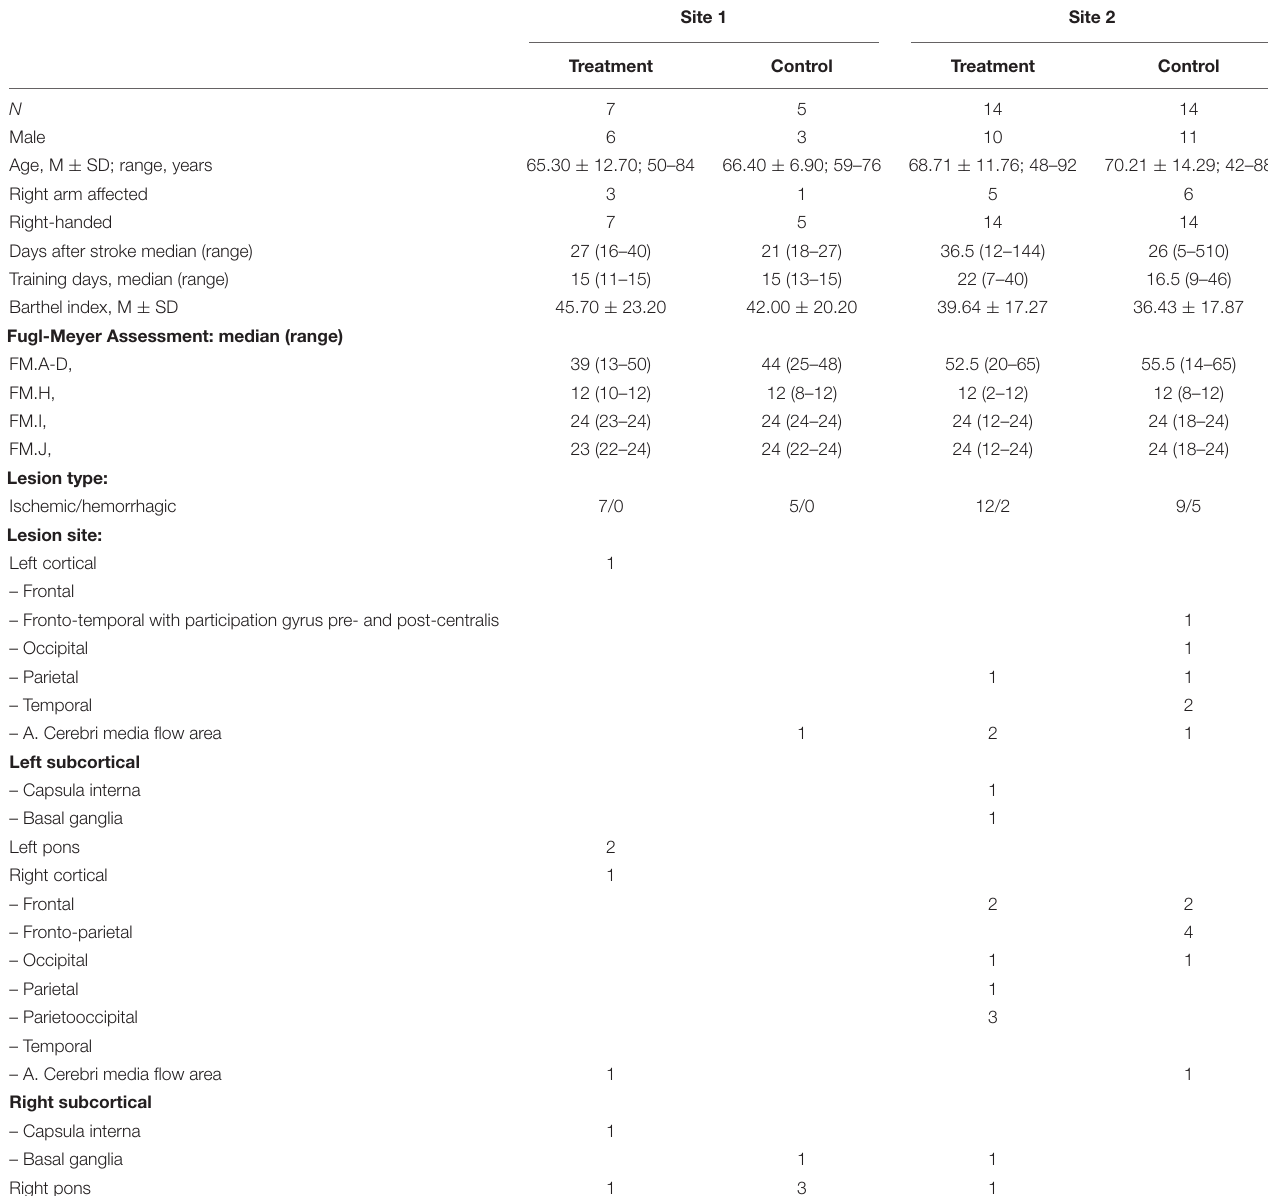
TABLE 1 | Patient